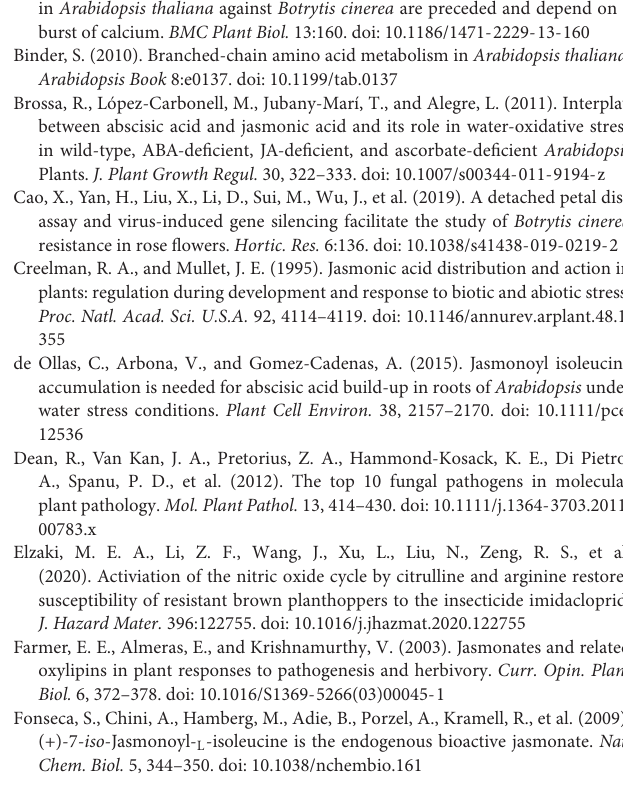
Supplementary Figure 1 | Transcript level of jasmonate (JA)-responsive genes on B. cinerea infection. Supplementary Figure 2 | Transcript level of JA-responsive genes on MeJA treatment. Supplementary Figure 3 | lib mutant exhibits normal aboveground growth and development. Supplementary Table 1 | Amount of free amino acids in the leaves of wild type, lib , and jar1-1 seedlings. Supplementary Table 2 | Primers used for quantitative real-time PCR